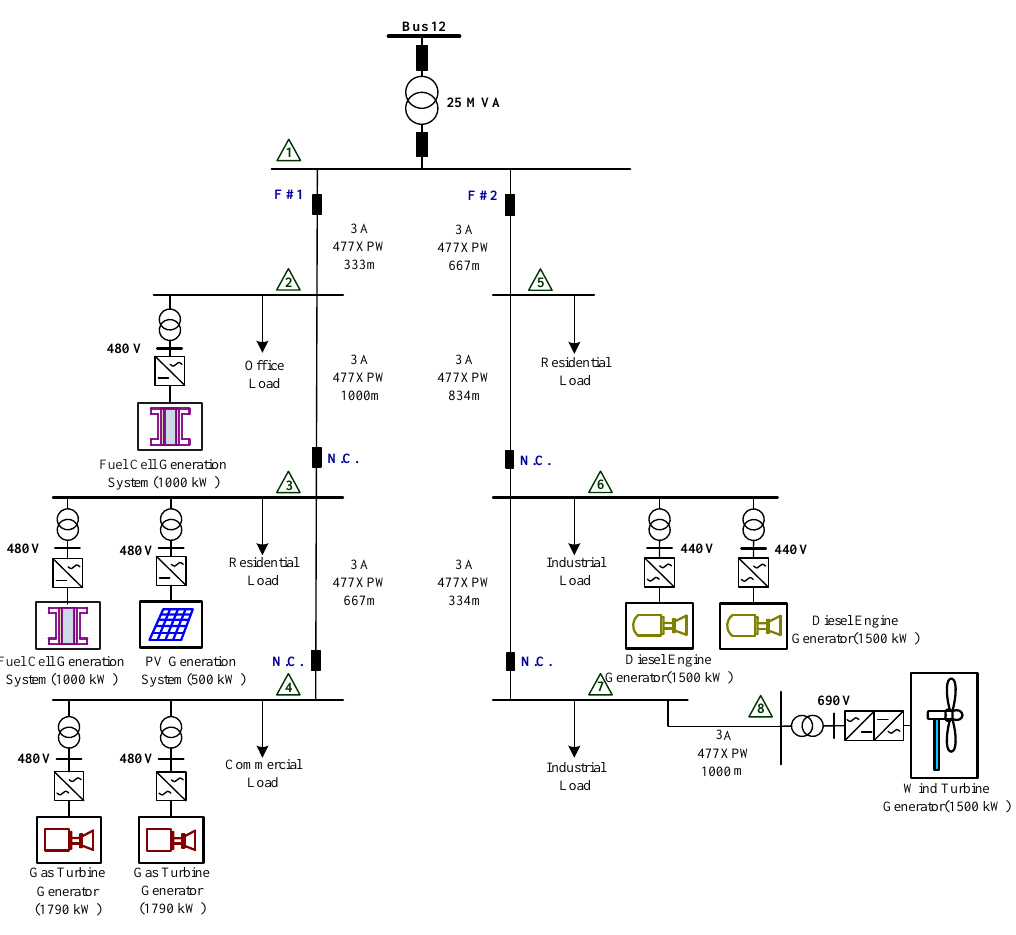
Figure 5. MG-A connected at bus 12.